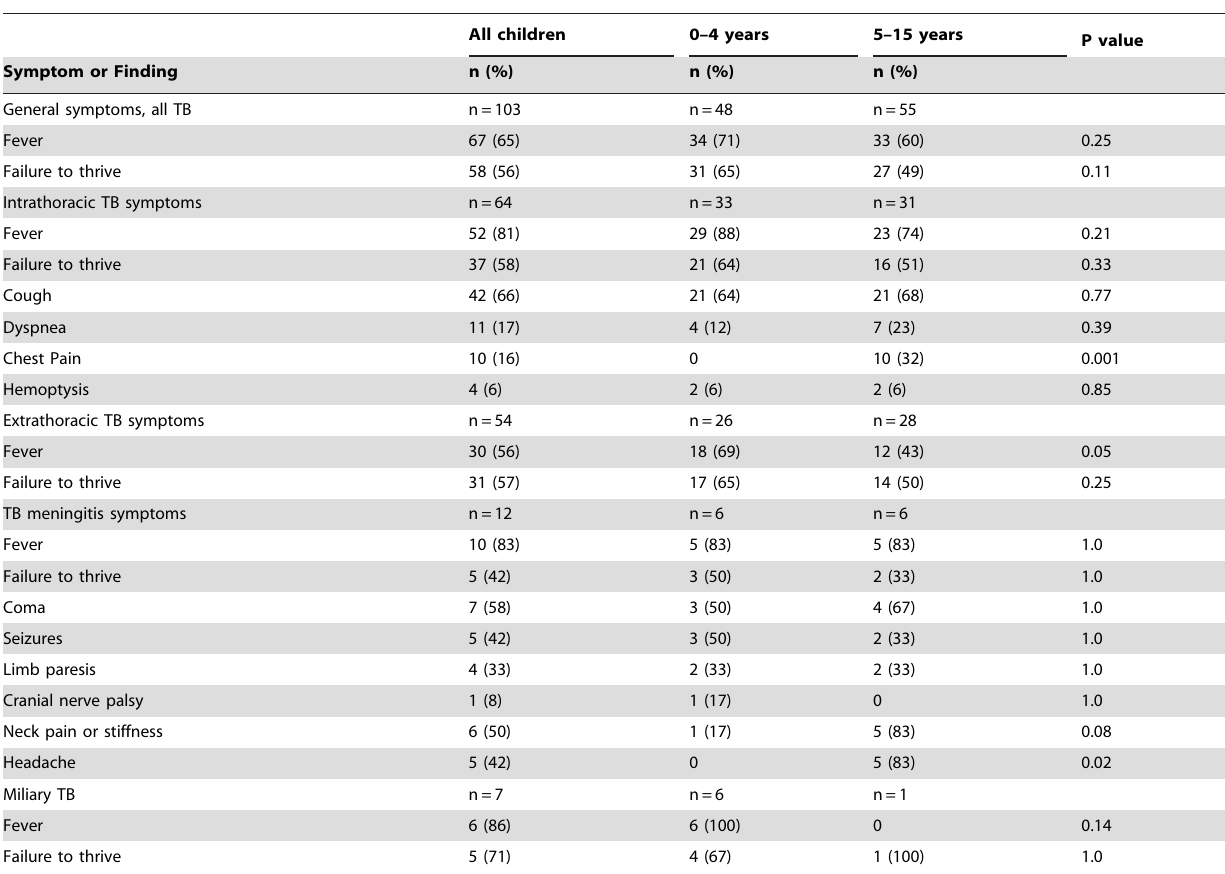
Table 3. Presenting Symptoms According to Site of Disease and